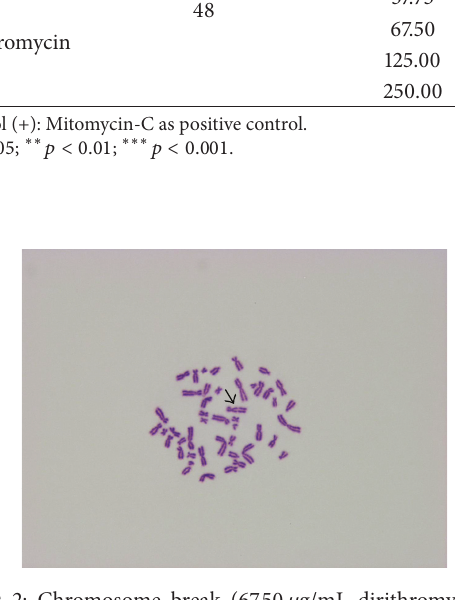
Figure 2: Chromosome break (67.50 𝜇 g/mL dirithromycin, 24 h treatment, C ).